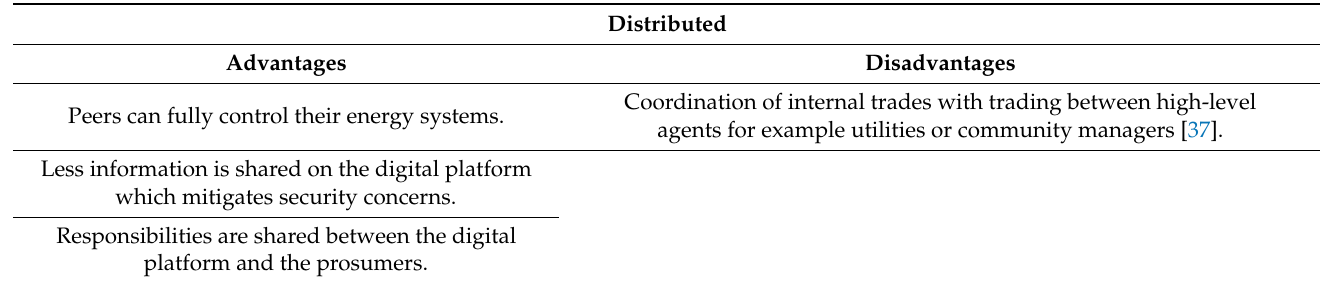
Table 5. Advantages and disadvantages—Distributed P2P-ET market. Table based on own interpre- tation from Section